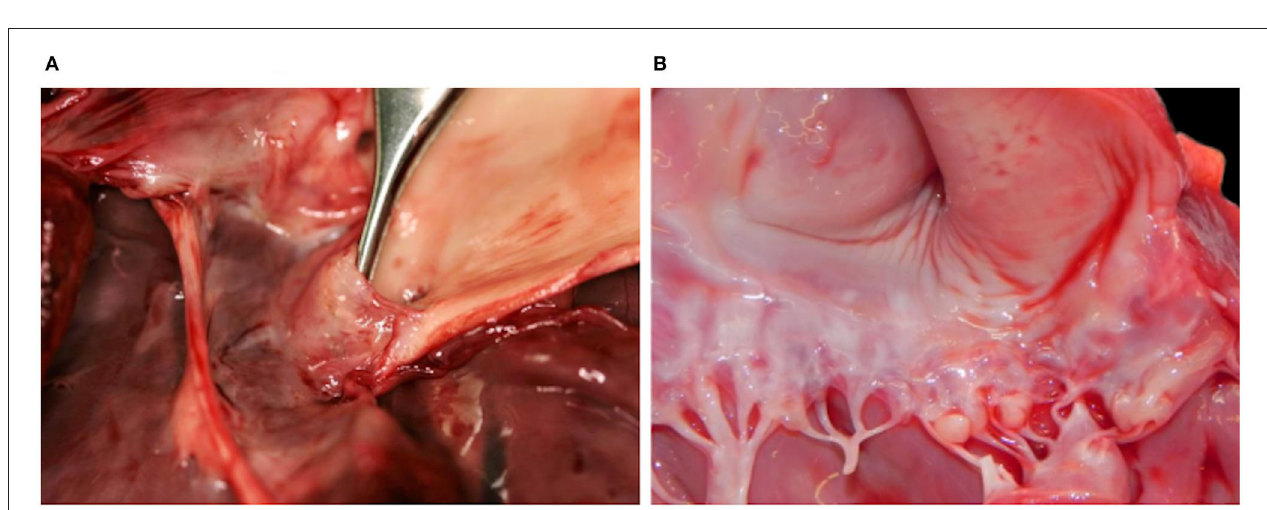
FIGURE 2 | uneven surface with variably extensive minimally to mildly depressed areas and discrete multifocal light tan foci (inset); (D) case 4, cross-section: moderately expanded left ventricle lumen; (E) case 5, diaphragmatic view: moderate cardiomegaly with relatively normal profile and multifocal to coalescent light tan foci; (F) case 5, cross section: severe dilation of both ventricles; (G) case 6, diaphragmatic view: moderate cardiomegaly with elongated ovoid shape, lateral bulging of the right ventricle, multifocal to coalescent light tan foci and uneven surface; (H) case 6, cross-section: bilateral ventricular hypertrophy.